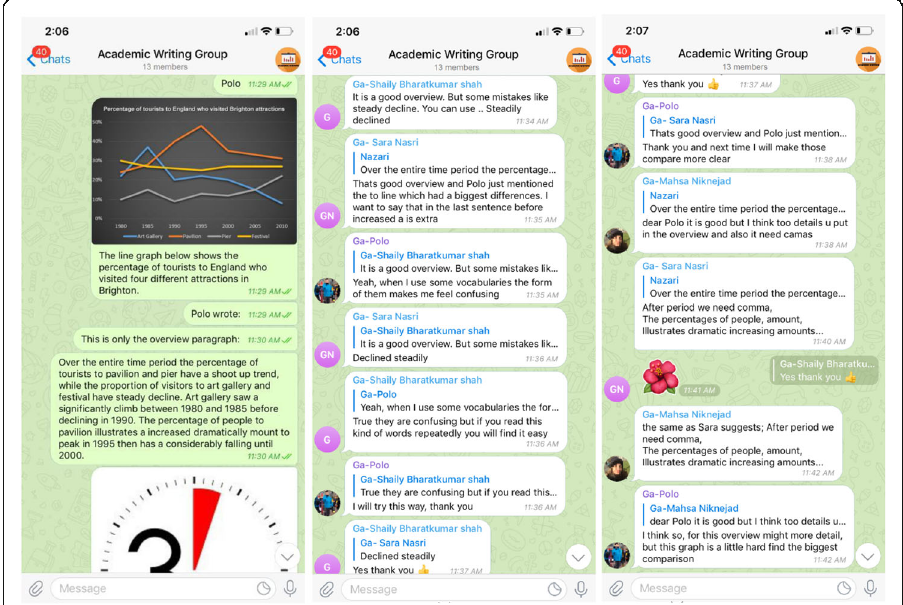
Fig. 1 A sample of peer review exchange in